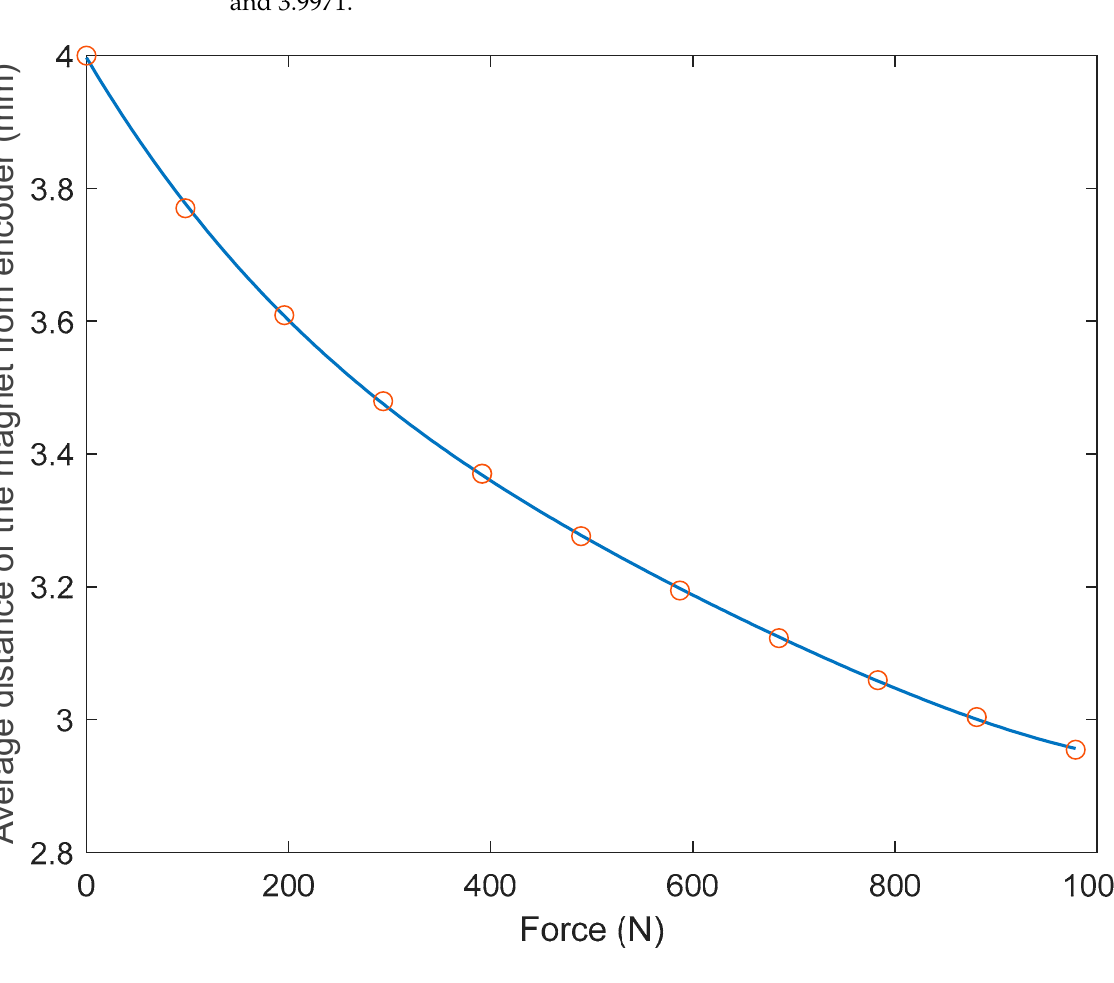
Figure 13. The change of magnetic flux density with respect to the relative distance between the magnet and the magnetic field transducer ( left ). The change of magnetic flux density with respect to axial force ( right ).